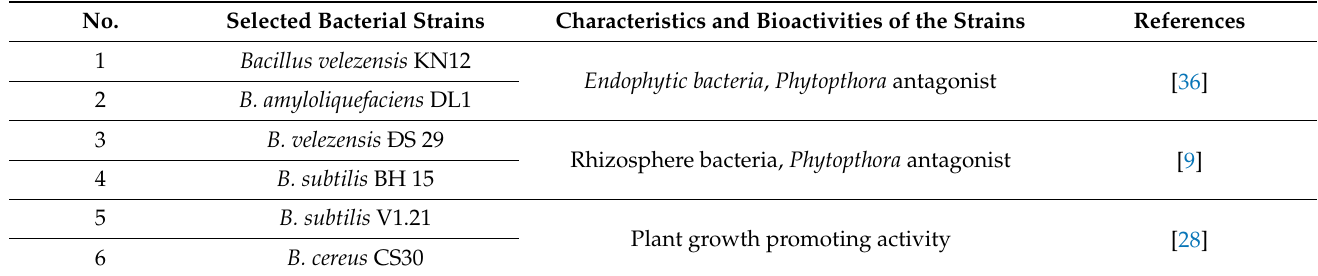
Table 1. The bacterial strains used for application in the black pepper farm.